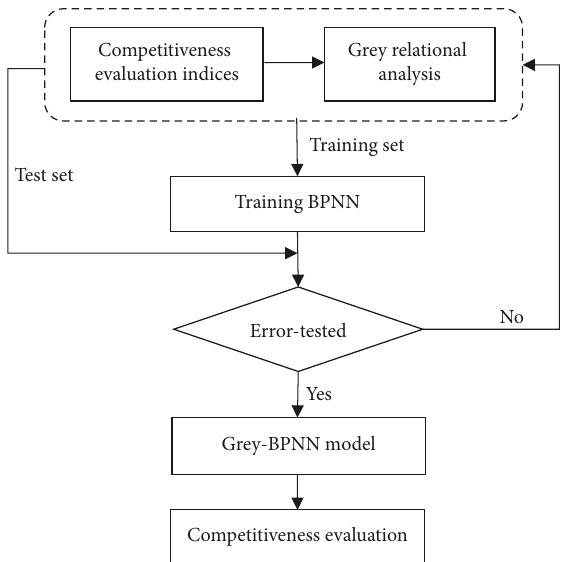
Figure 8: Grey-BPNN model construction process.